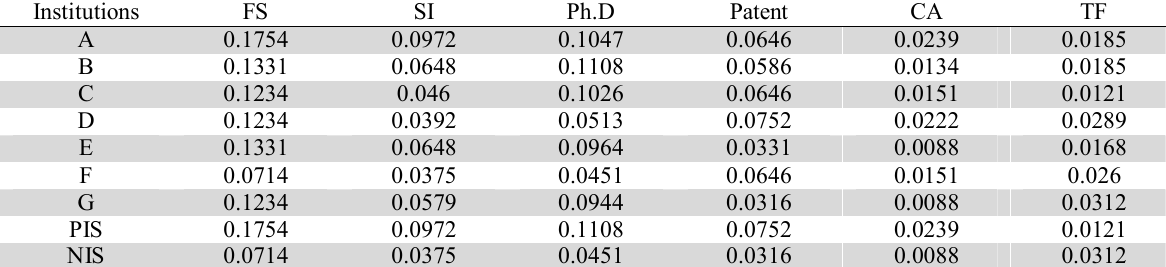
Weighted normalized performance score matrix